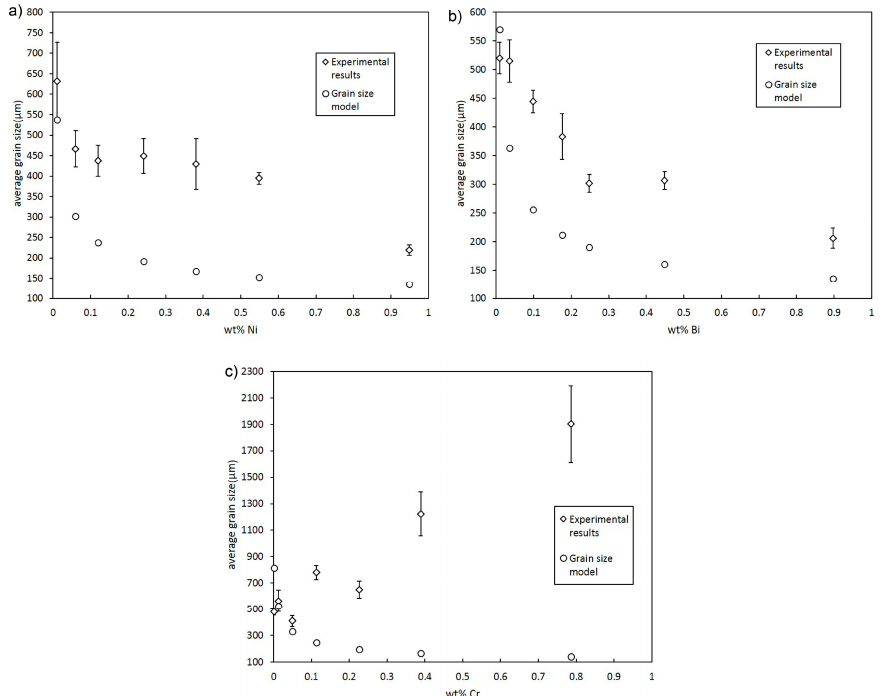
Figure 4. Grain size of Cu with a range of Ni ( a ), Bi ( b ) and Cr ( c ) concentrations.